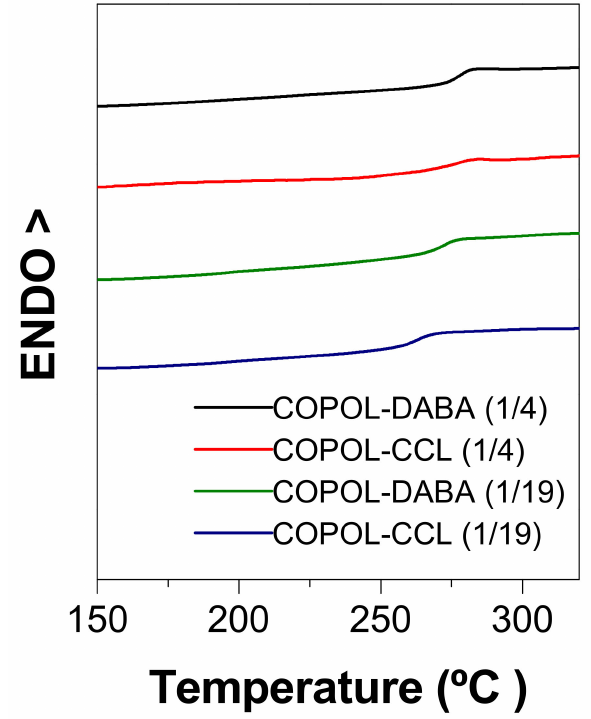
Figure 9. DSC of copolyimides and their corresponding crosslinked